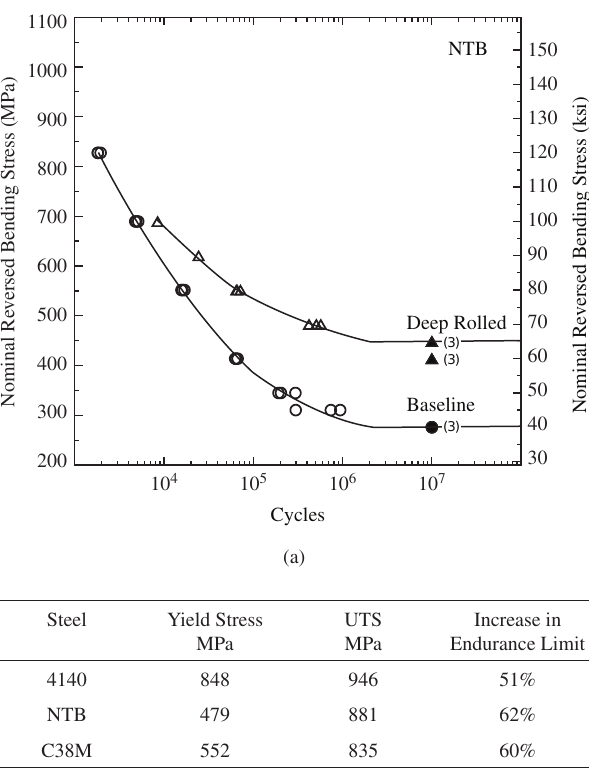
Figure 7. a) A comparison of deep rolled and baseline bending fatigue behavior for the NTB steel; and b) a summary of the extent of improvement imparted